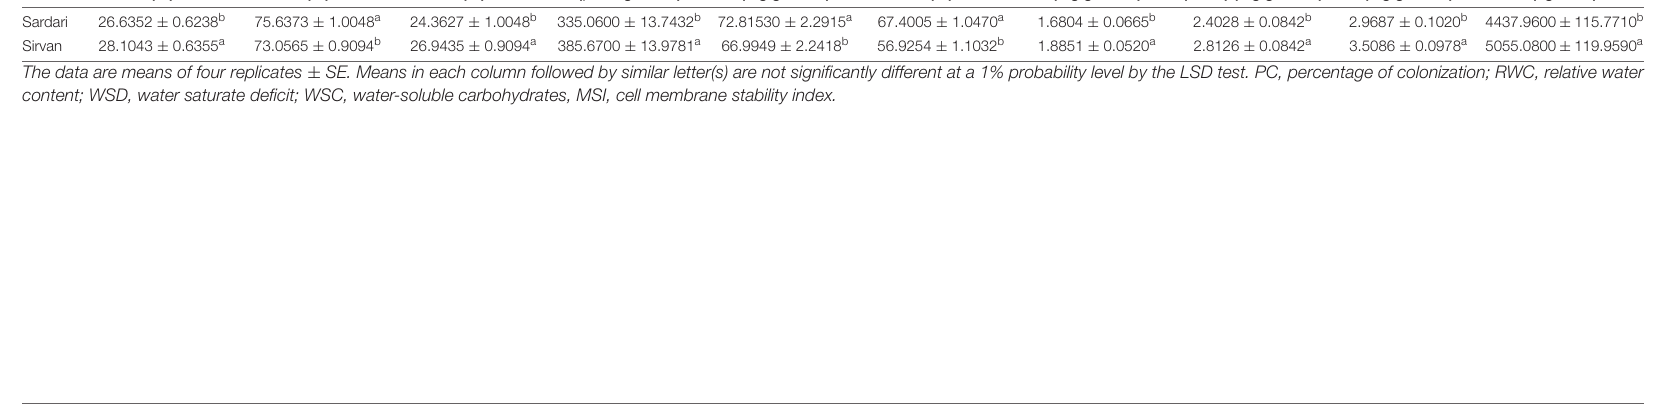
TABLE 6 | Mean comparisons of simple main effects of bio-fertilizers on some traits in the wheat plant in 2017–2018.